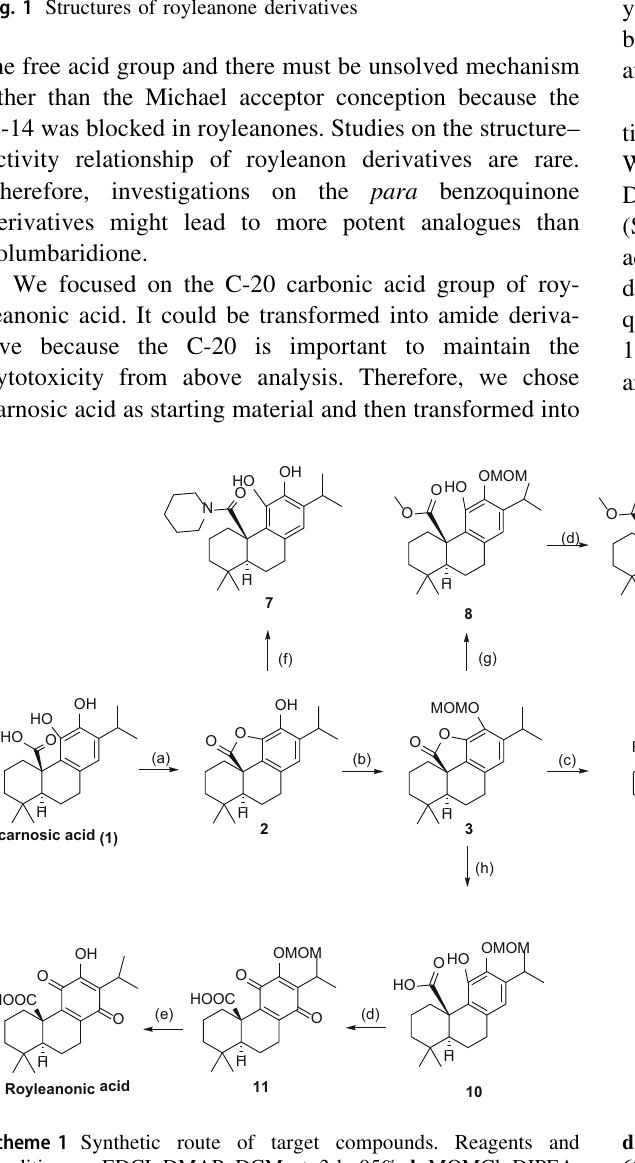
Fig. 1 Structures of royleanone derivatives